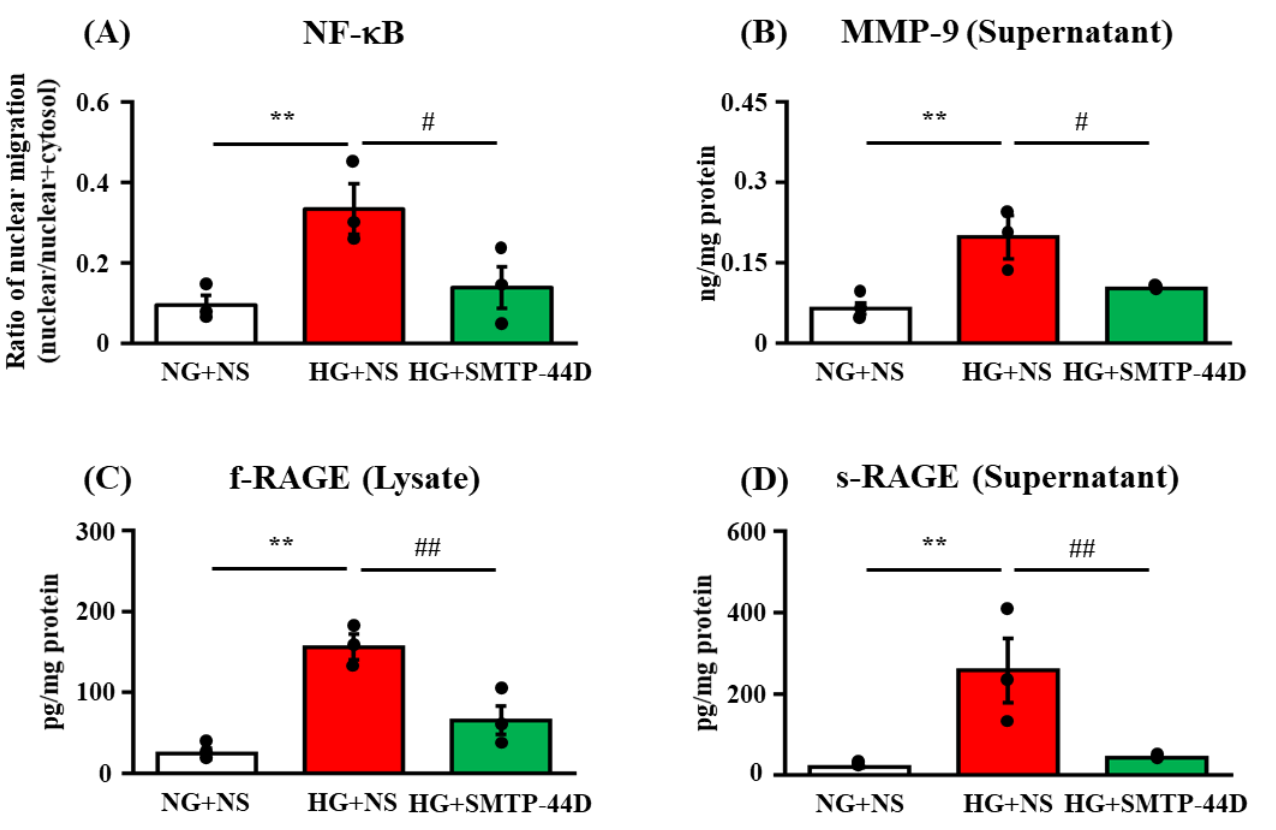
Figure 2. Nuclear migration of NF- κ B ( A ) and the levels of MMP-9 ( B ), f-RAGE ( C ), and s-RAGE ( D ) in response to SMTP-44D in IMS32 cells under high glucose conditions. IMS32 cells were incubated with SMTP-44D (30 µ M) from 48 to 96 h after the HG treatment. The nuclear migration of NF- κ B ( A ) and the levels of MMP-9 ( B ), f-RAGE ( C ), and s-RAGE ( D ) were determined 96 h after the HG treatment. The data are expressed as the mean ± S. E. M. ( n = 3). ** p < 0.01 vs. NG + NS group; # p < 0.05, ## p < 0.01 vs. HG + NS group by one-way analysis of variance followed by Bonferroni test. NG, normal glucose; HG, high glucose; NS, normal saline.